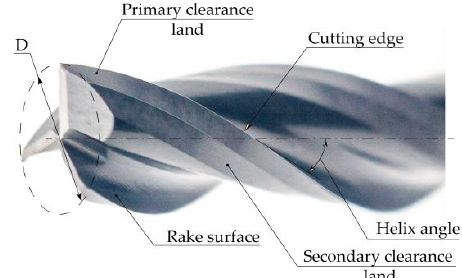
Figure 1. Photograph of a 3-mm-diameter end mill with a 30-degree angle of the chip groove inclination.